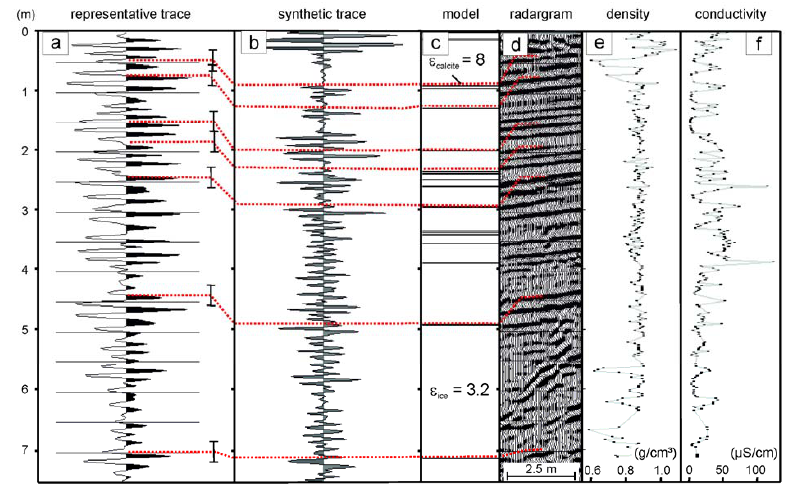
Figure 10: Recorded reflection bands from GPR and synthetic data based on the interpreted layers of calcite powder from the core drilling (May et al., 2010) at the location Eisriesenwelt: (a) representative GPR signal (stacked from 10 individual traces), (b) synthetic signal, (c) GPR permittivity model, (d) recorded reflection bands, (e) density profile (May, personal communication, 2009), (f) electrolytic conductivity after May et al., 2010. The latter is shown for completeness. The red lines denote layers which produce significant reflections in the synthetic data and that can be correlated with ( a and d ). The error bars in (a) show the estimated uncertainty of the GPR signal.